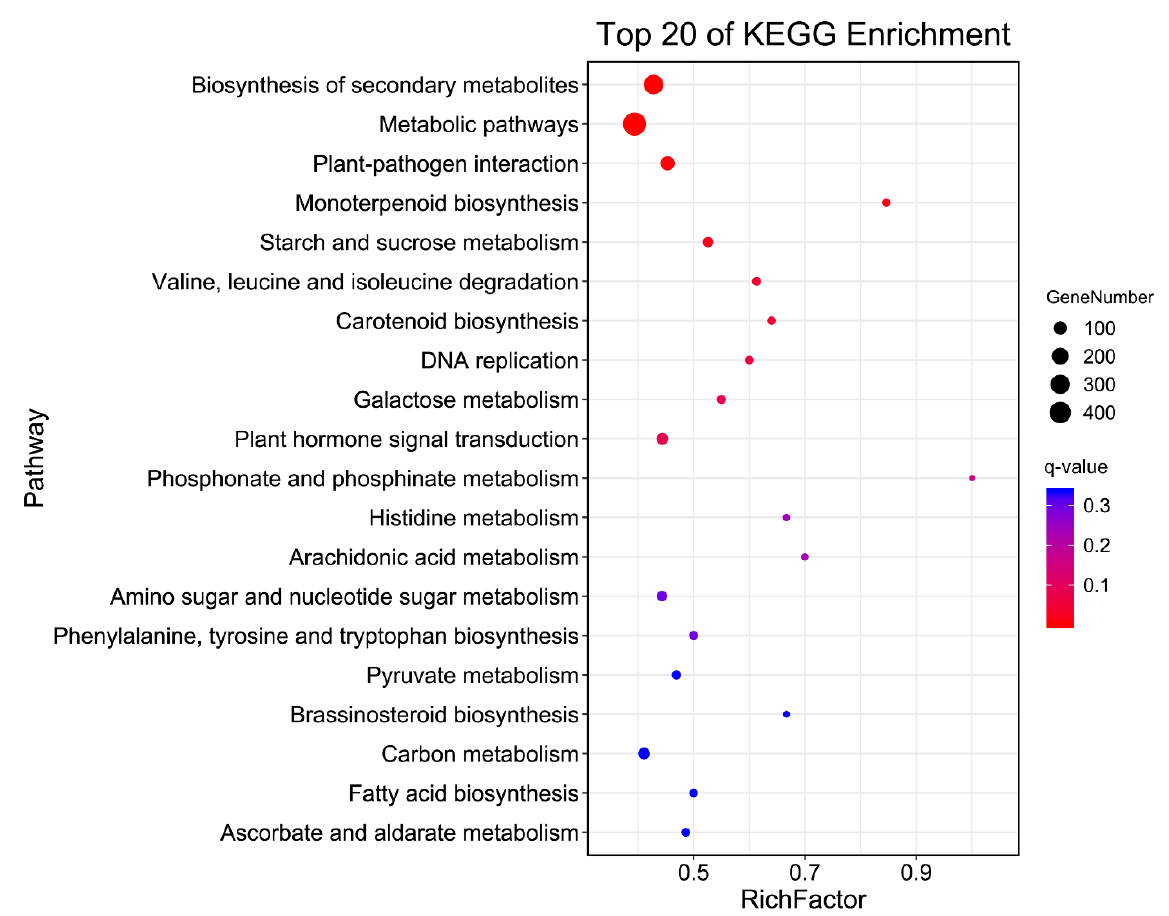
Figure 2. GO functional classification annotation of differentially expressed genes of pecan in comparison of abscised fruitlets vs. persisting fruitlets at 35 DAA.